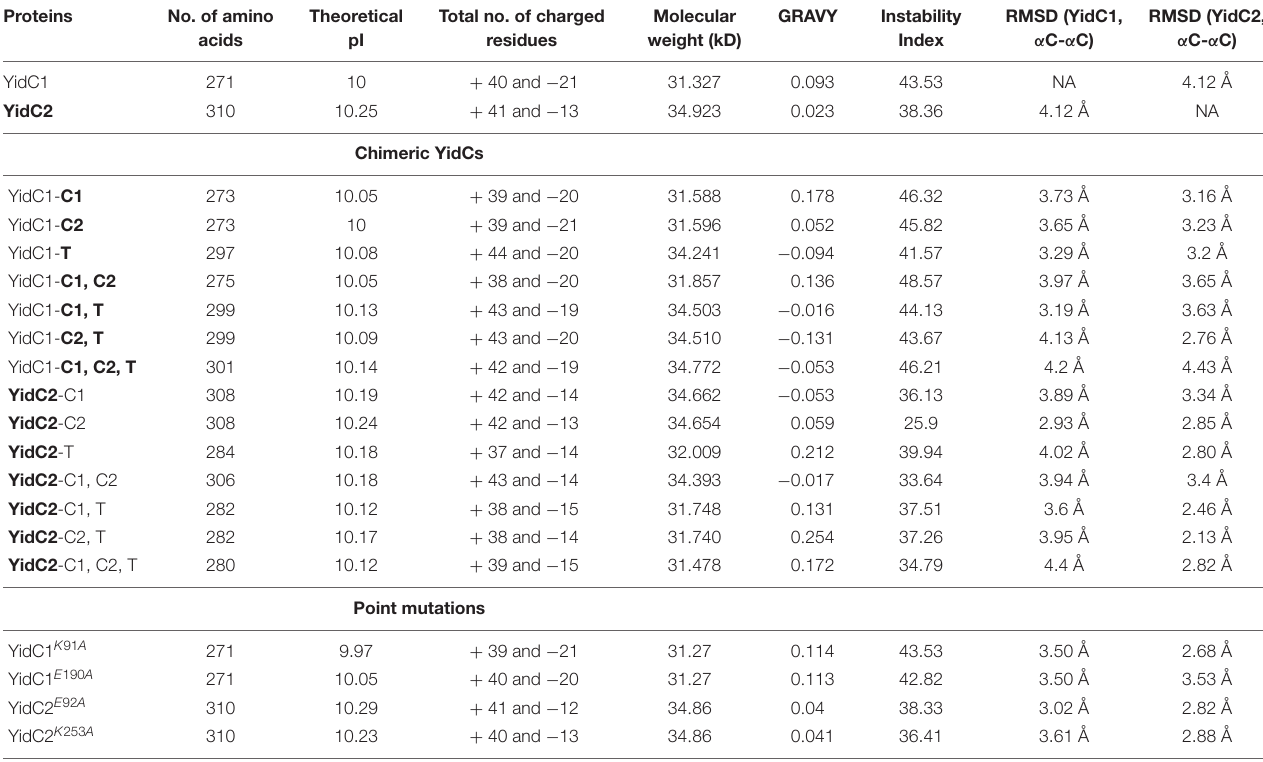
TABLE 1 | Physico-chemical evaluation of YidC1 and YidC2 chimeric polypeptides. Proteins No. of amino